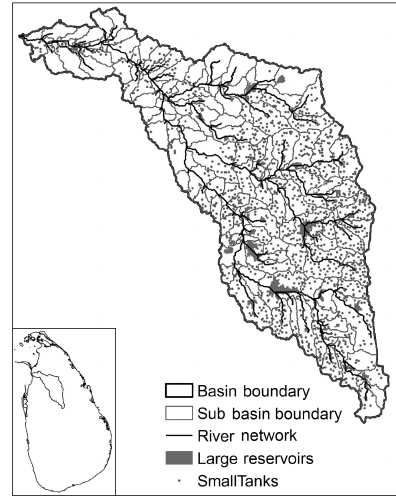
Figure 1. The Malwatu Oya basin and river